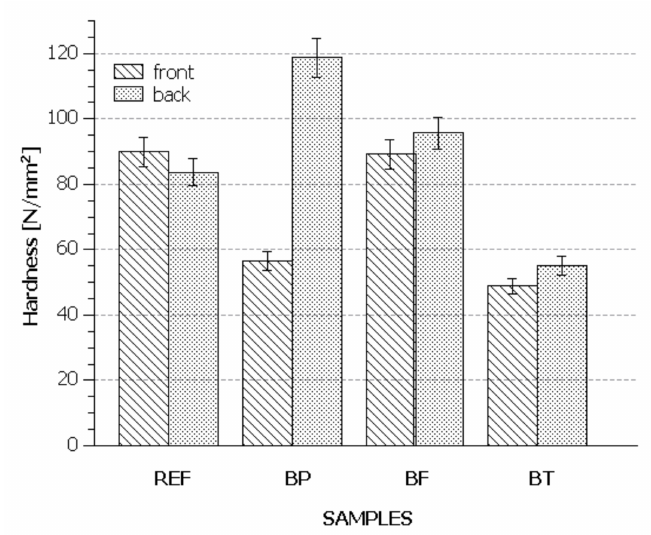
Figure 16. Hardness of EP (REF) sample and EP composites reinforced with basalt powder (BP), basalt fibre (BF) and basalt textile